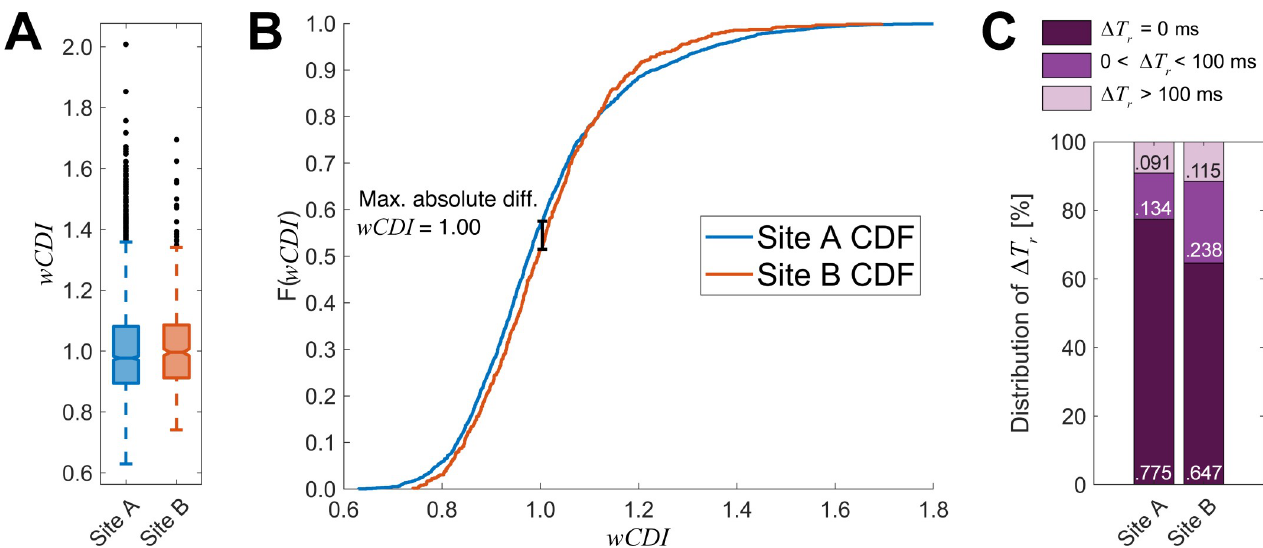
Fig 5. Mechano-NPS results from different instrumentation sets at location Sites A and B are highly reproducible. (A) Box plots of wCDI for MCF-10A cells analyzed at Site A and Site B. Black points represent cells with outlier values of wCDI , defined as 1.5 times the inter-quartile range. Notches represent 95% confidence intervals for the true sample median for each distribution. (Site A n = 1960, Site B n = 625). (B) Empirical CDFs for Site A and Site B wCDI data. A two-sample Kolmogorov-Smirnov test determined that these data are sampled from different distributions ( p = 0.042; Site A n = 1960, Site B n = 625), with the maximum absolute difference occurring at wCDI = 1.00. (C) Stacked bar graph representing the relative categorical frequency of MCF-10A cells recovering instantaneously ( Δ T r = 0 ms), within the finite time window (0 < Δ T r < 100 ms), or failing to recover within the finite time window ( Δ T r > 100 ms). Chi- squared analysis determined that these frequencies were statistically significantly different ( p < 0.0001; Site A n = 1960, Site B n = 625; see S6 Table).